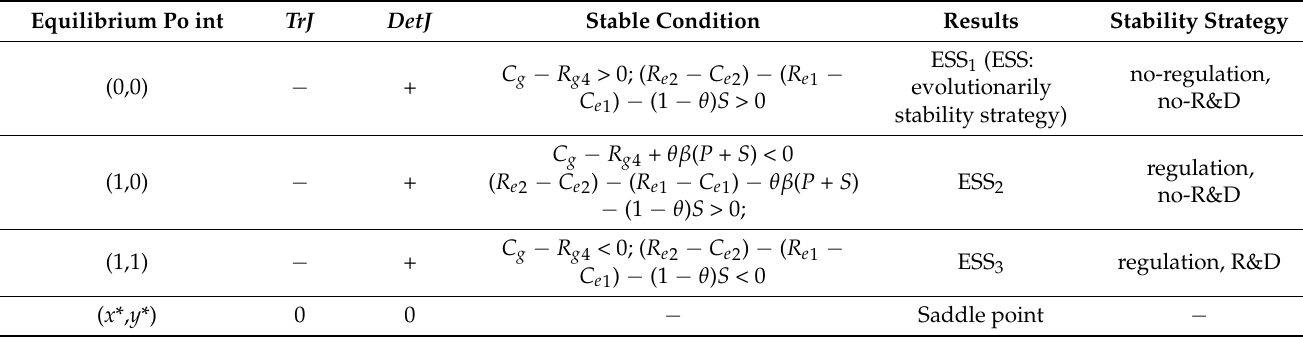
evolutionarily stability strategy)